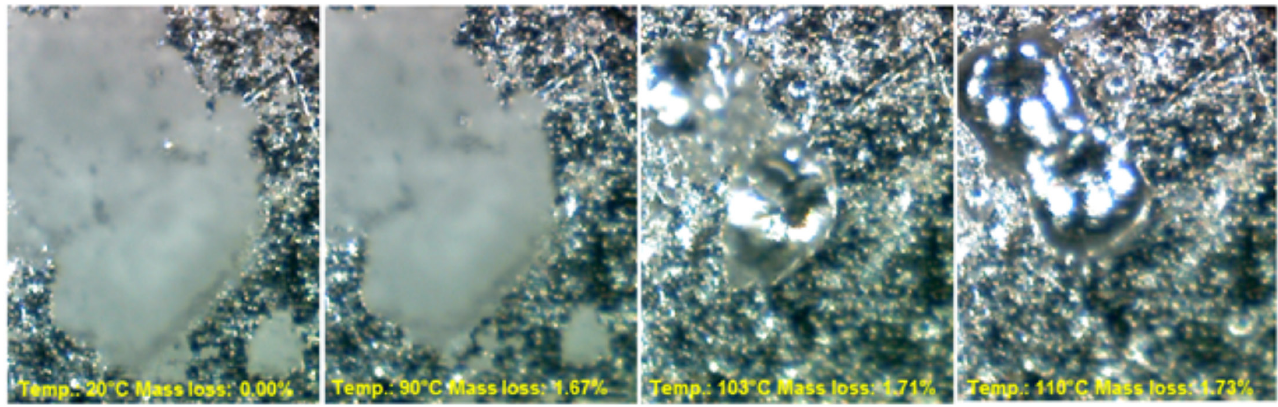
FIGURE 2 – Imaging-DSC photomicrographs of